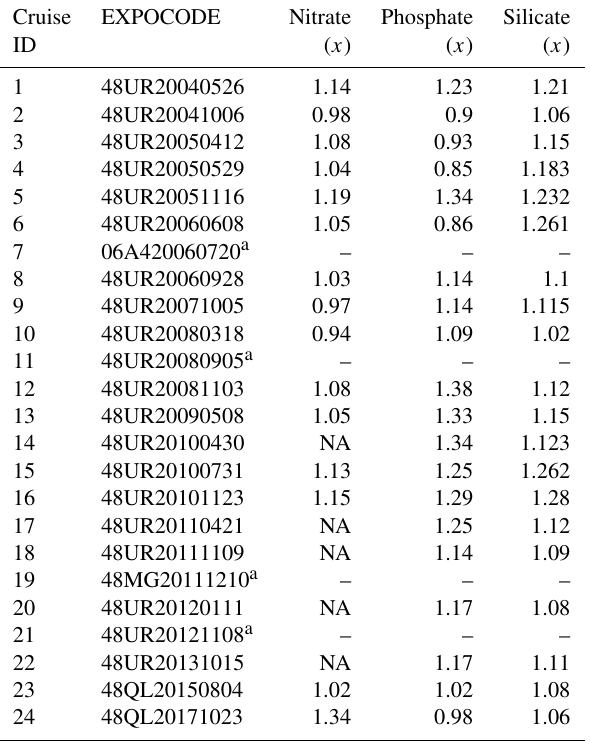
Table 5. Summary of the suggested adjustment for nitrate, phos- phate, and silicate resulting from the crossover analysis. Adjust- ments for inorganic nutrient are multiplicative. NA denotes not ad- justed, i.e. data of cruises that could not be used in the crossover analysis, because of the lack of stations or because data are outside the spatial coverage of reference